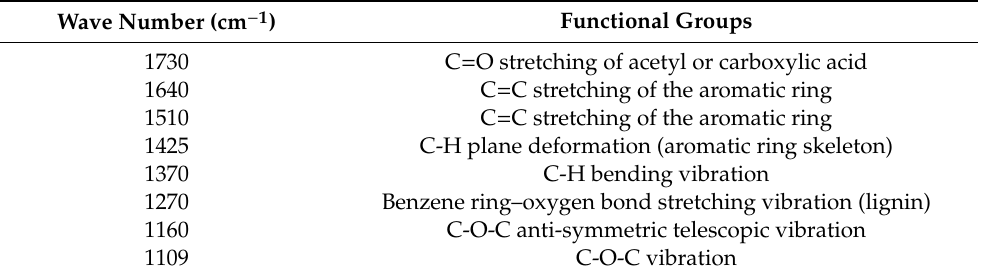
Figure 1. Fourier-transform infrared (FTIR) spectra: ( a ) untreated radiata pine (RP), ( b ) sodium bicarbonate-treated RP, ( c ) ozone-treated RP. Table 1. Main bands of the infrared spectrum of RP and their functional groups.